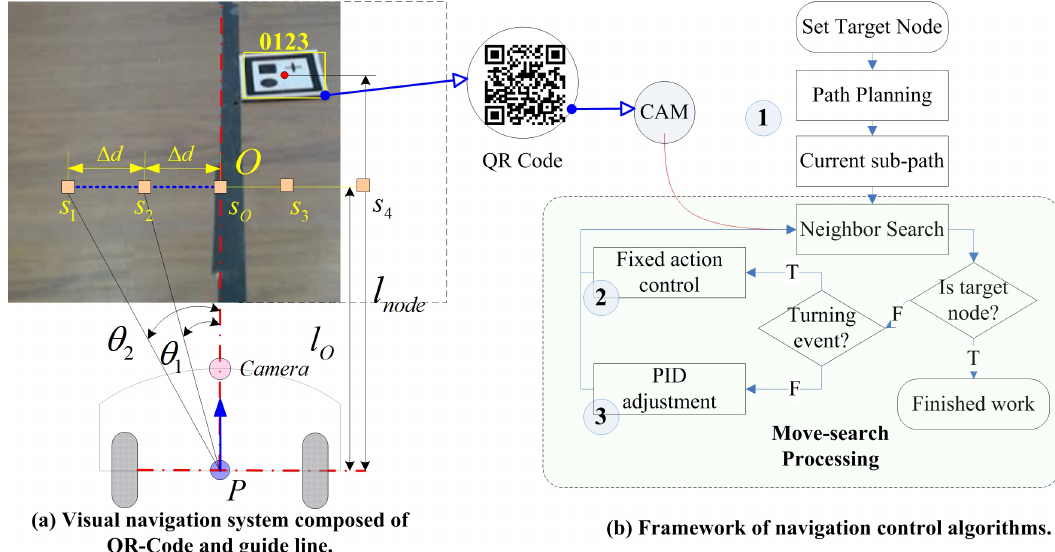
Figure 7. High-precision navigation scheme based on guide line and QR code